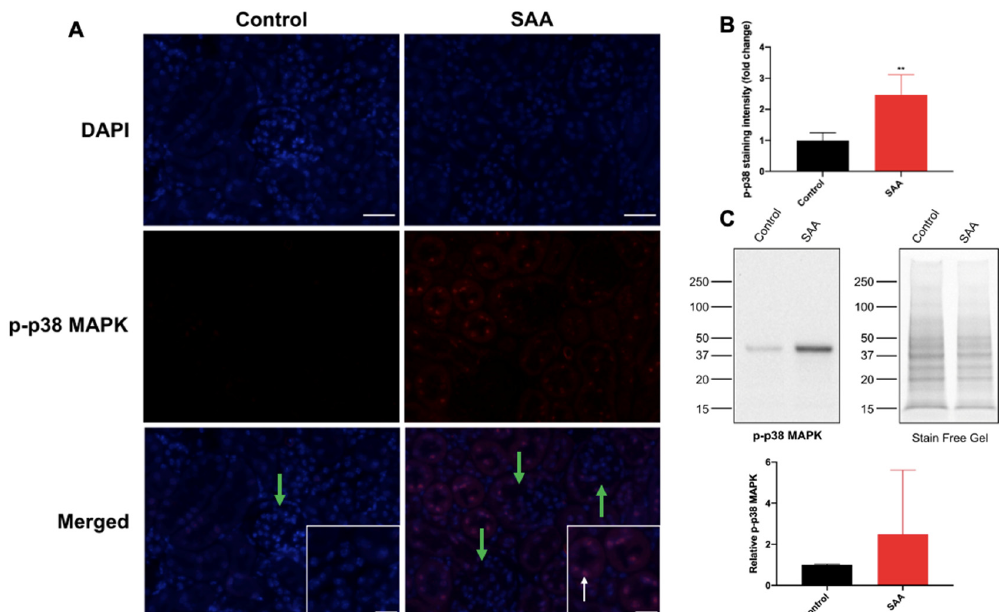
Figure 6. SAA administration stimulates p-p38 MAPK expression in the renal cortical tissue. ( A ) Male ApoE − / − mice were randomly allocated to vehicle control (administered 100 µL PBS every 3 days for 2 weeks) and the SAA group (administered 12 µg SAA protein every 3 days for 2 weeks). Kidneys were harvested 4 weeks after treatment cessation and fixed in situ before embedding and sectioning (5 µm). Renal sections were dewaxed then rehydrated before undergoing heat-induced antigen retrieval. NF-kB p-p65 expression was assessed using immunofluorescence microscopy. Slides were visualised at 40× magnification (scale bar = 20 µm); images are representative of at least 4 fields of view for each sample. Nuclei were stained with DAPI (blue) and p-p38 MAPK with an appropriate Opal fluorophore (red). White arrow indicates p-p38 MAPK+ staining localised to renal epithelial cells, which was absent in glomerular endothelium (glomeruli indicated by green arrow). Insets show higher magnification (scale bar = 10 µm) images of renal tubular epithelial cells with p-p38 MAPK+ staining colocalised to nuclei with some cytoplasmic staining. Representative images show cortical fields from n = 5 (control), n = 6 (SAA). ( B ) Immunostaining was quantified using a mean staining intensity for each field of view and averaged for each sample; data shown as relative mean ± SD. ** Different to control group; p < 0.001. ( C ) Western blot analyses of p-p38 MAPK were performed as described in the methods section. Homogenised renal tissue (20 µg protein) from the control and SAA groups were separated by SDS-PAGE. Proteins were transferred onto a membrane, blocked, then incubated with the appropriate antibodies. Membranes were imaged, and bands at 38 kD corresponding to p-p38 MAPK were identified and quantified using densitometry (ImageLab, version 6.0.1). All density data were normalised with total protein loading determined from corresponding stain free gel images. Data shown as relative mean ± SD.